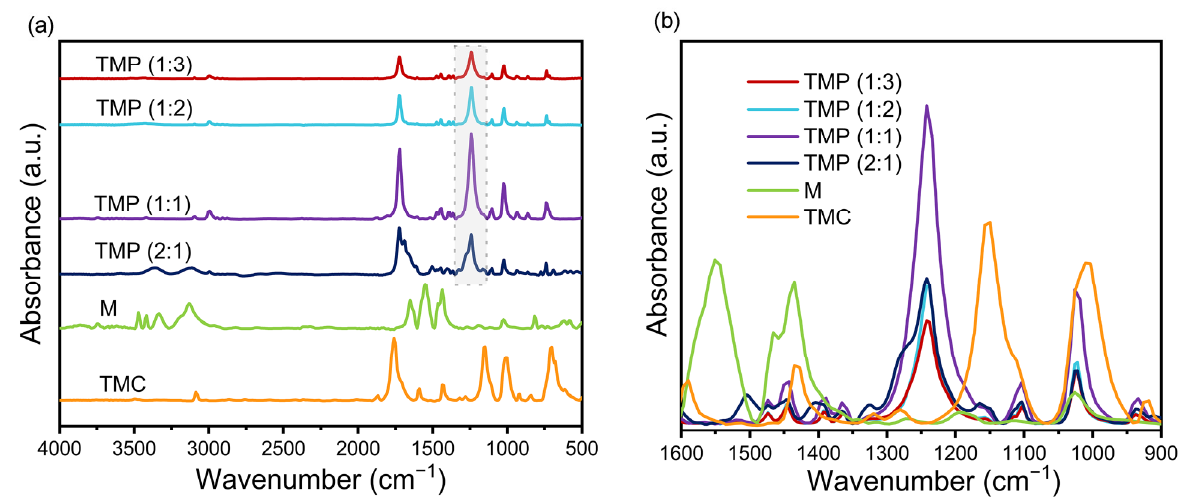
Figure 2. ( a ) Fourier transform infrared spectroscopy (FT-IR) of melamine (M), tricarbonyl chloride (TMC), and trimesoyl chloride–melamine copolymer (TMP) after baseline correction (500–4000 cm − 1 ); ( b ) FT-IR spectra of M, TMC, and TMP after baseline correction (900–1600 cm − 1 ).